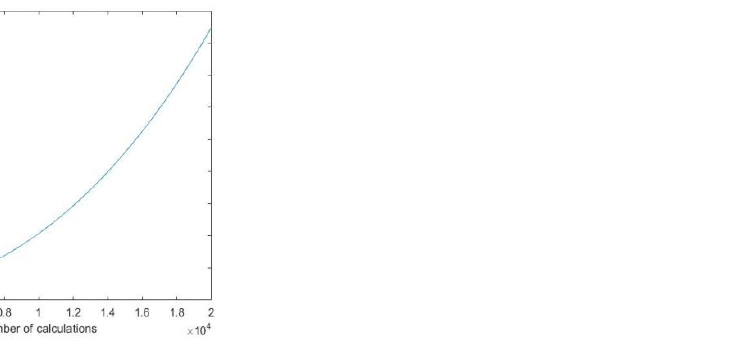
Figure 2. The change of c when the total times of objective function evaluation are set to 20,000. Inspired by DE, we add the mutation and crossover strategies to the